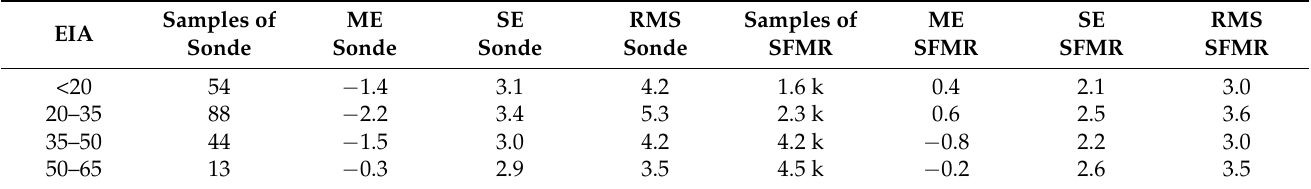
Table 6. HIRAD difference statistics with dropsonde and SFMR (reference–HIRAD) m/s as a function of binned EIA, where the binning is in respect to the reference. The mean error (ME), standard error (SE), and root mean squared error (RMSE) are given for